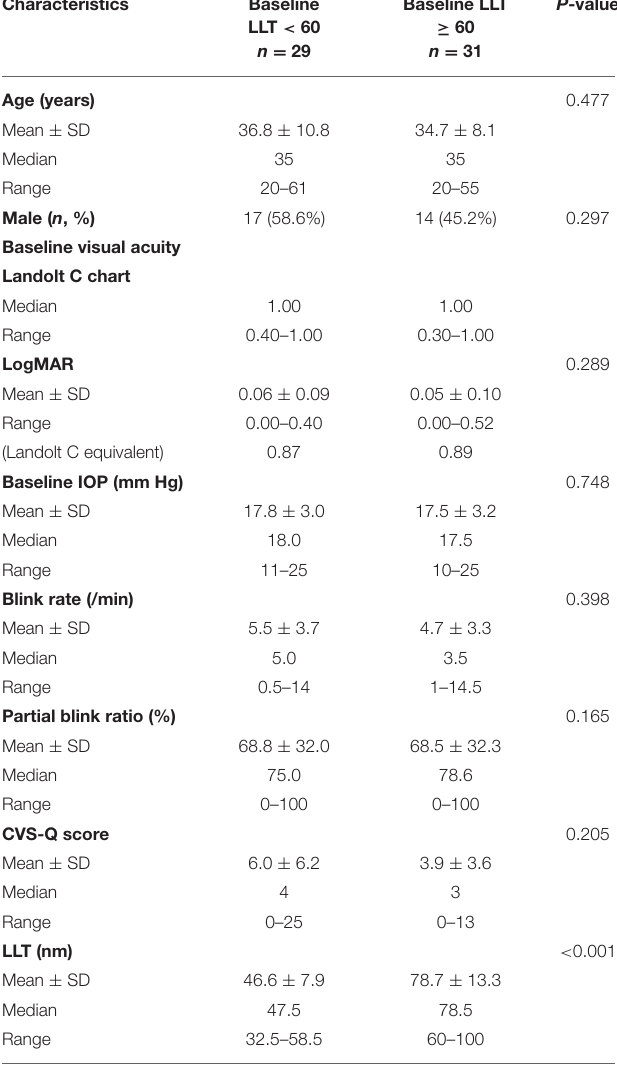
TABLE 3 | Participants characteristics based on their baseline lipid layer thickness.